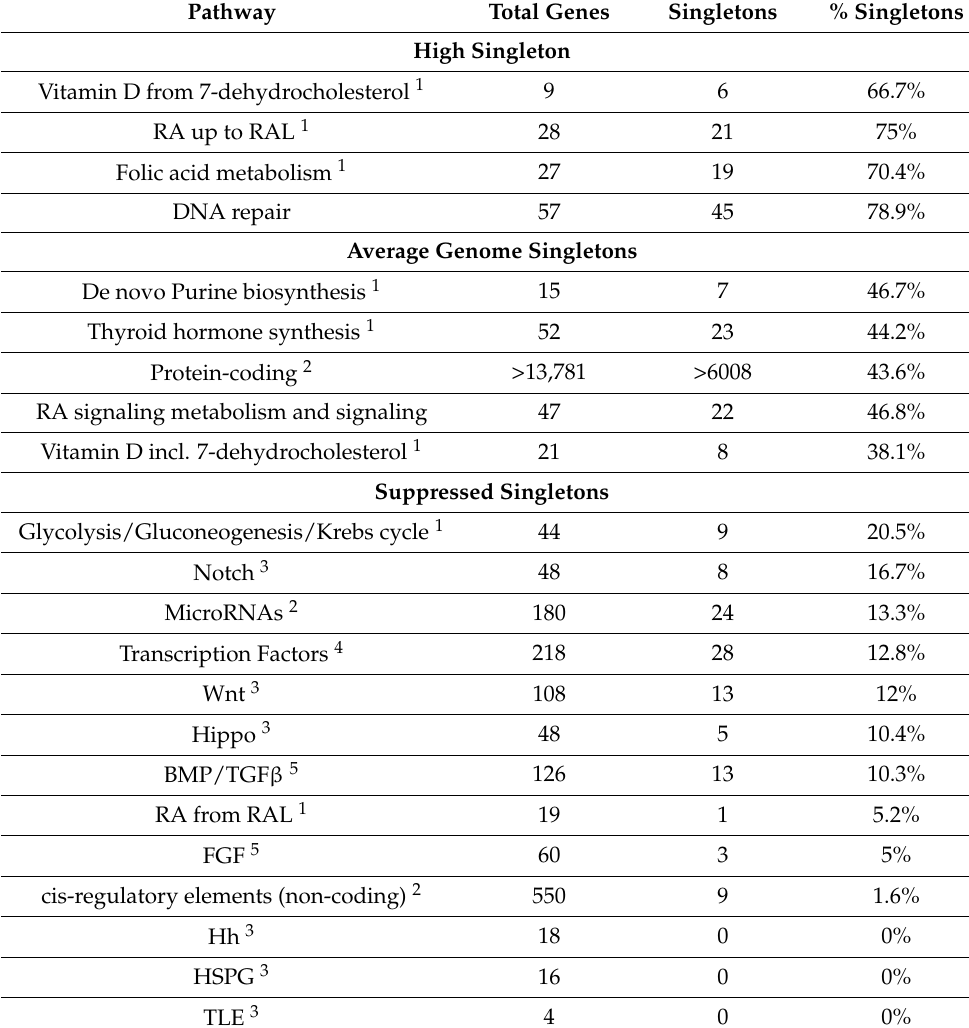
Table 2. Singleton distribution in Xenopus laevis metabolic and signaling